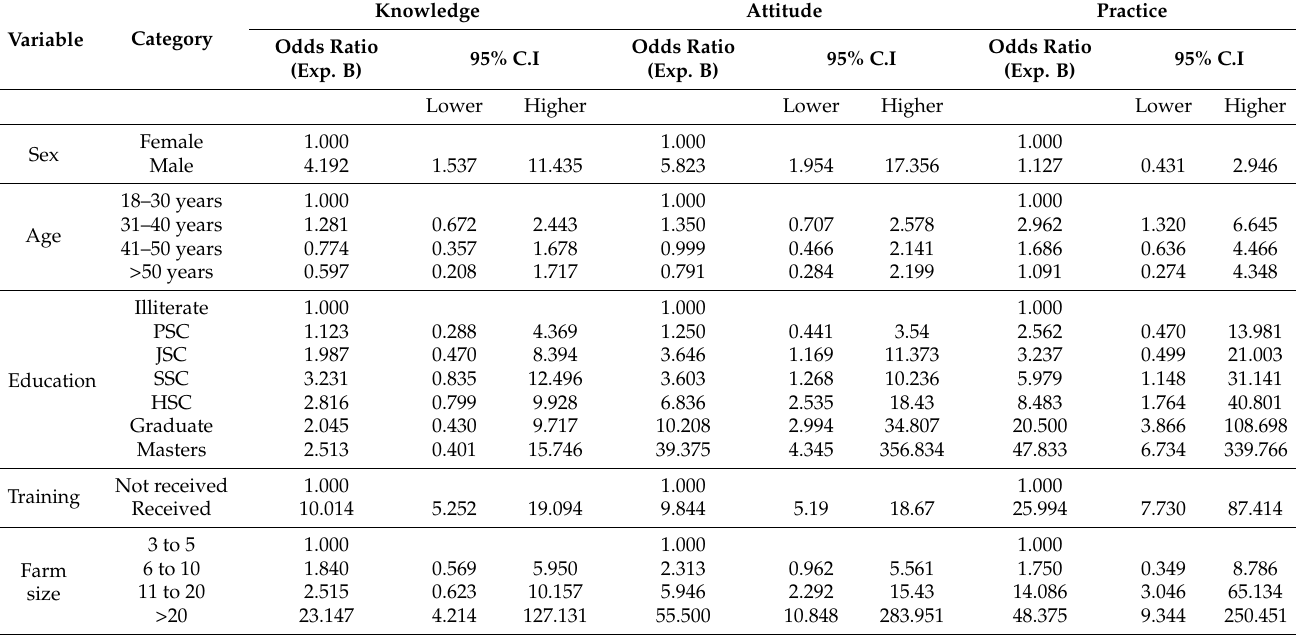
Table 3. Logistic regression analysis of the factors associated with respondents’ knowledge, attitudes, and practices of AMU and